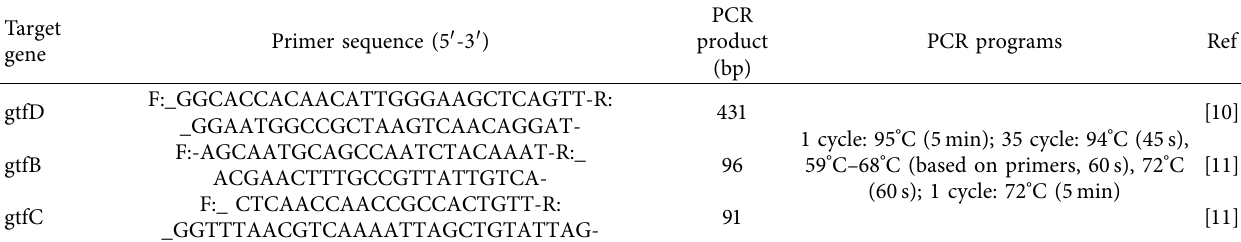
Table 1: Oligonucleotide sequences of primers and PCR amplification program.